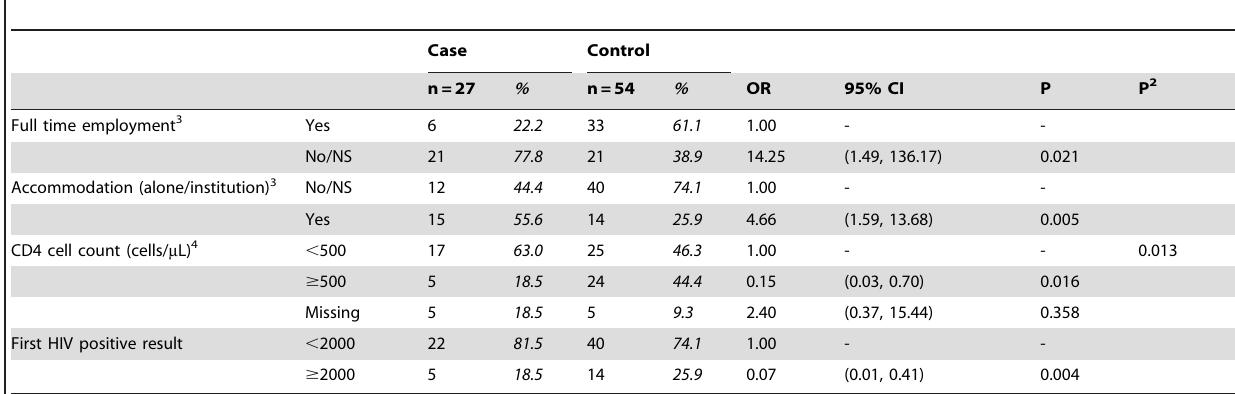
Table 3. Multivariate conditional logistic regression of determinants of suicide and accidental/violent death 1